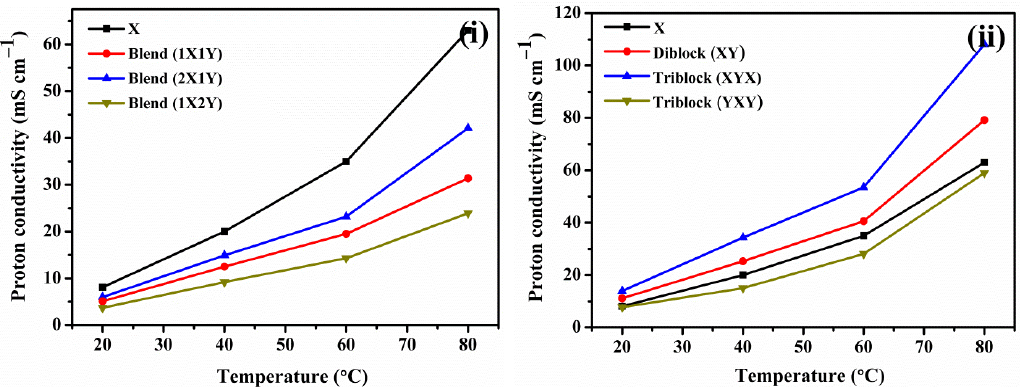
Figure 9. Proton conductivity plots of ( i ) blend and ( ii ) block copolymer membranes measured under 100% RH. Table 2. Water uptake, swelling ratio, and activation energy of prepared membranes